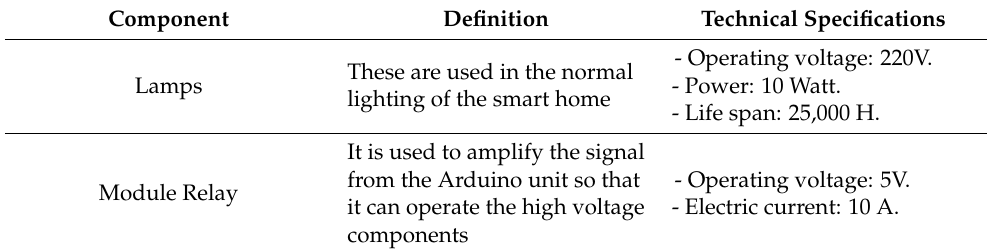
Table 2. The main components used to control the operation of lighting and sockets.